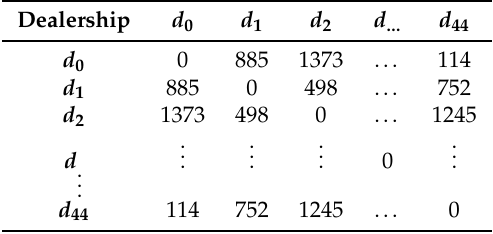
Table 1. Distance (in kilometers) between dealerships.